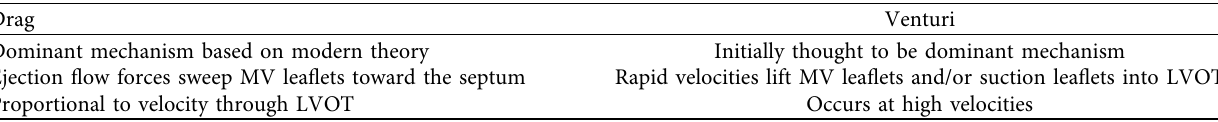
Table 1: Kinetic mechanisms thought to cause systolic anterior motion of the mitral valve that may then cause left ventricular outfow tract obstruction [1, 10, 11]. Drag Venturi Dominant mechanism based on modern theory Initially thought to be dominant mechanism Ejection fow forces sweep MV leafets toward the septum Proportional to velocity through